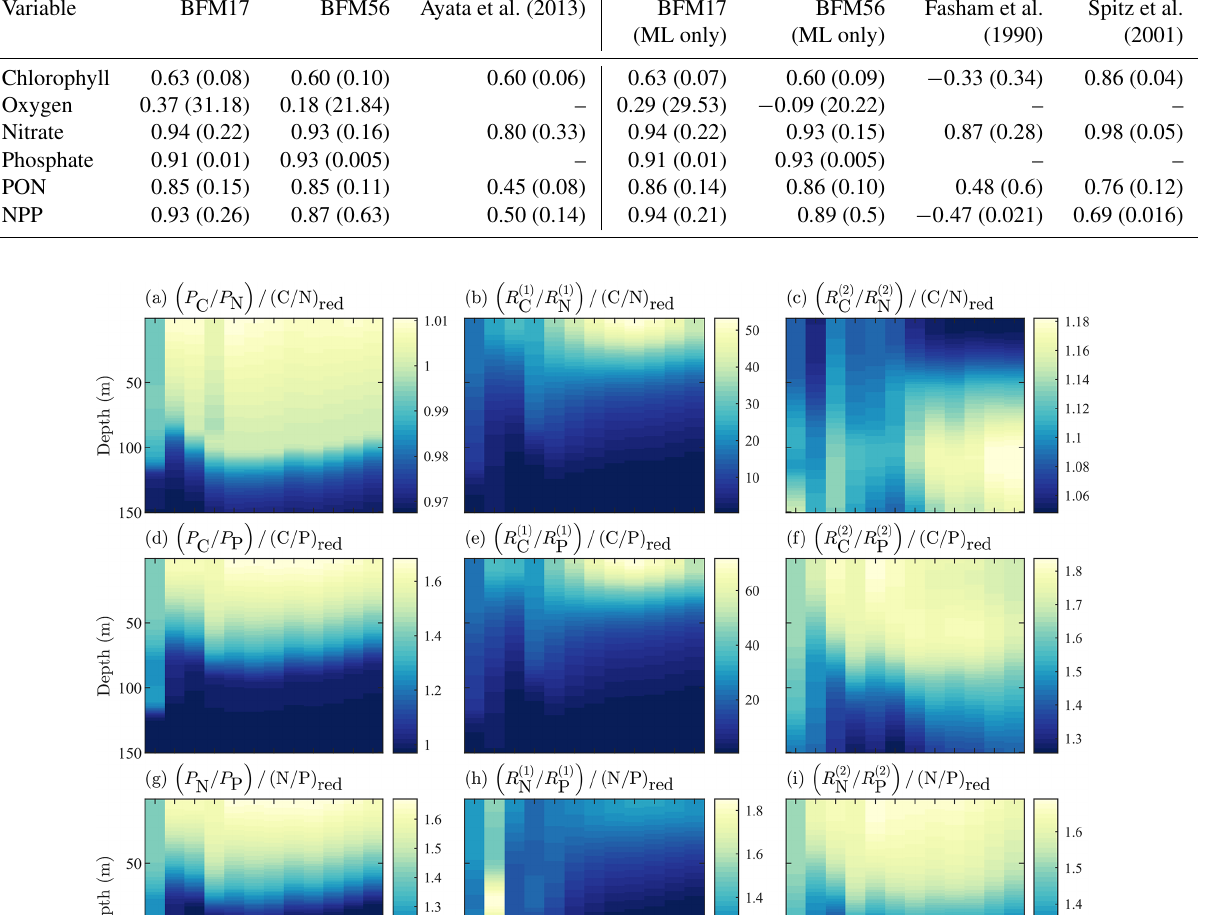
Table 3. Correlation coefficients (and RMSE in parenthesis) between BATS target fields and model data for BFM17, BFM56, and several example models of similar complexity. The first set of BFM columns is calculated over the entire water column, while the second set (denoted with “ML only”) is calculated over the monthly mixed layer depth only (defined as the depth at which the density is 0.2kgm − 3 greater than the surface density).